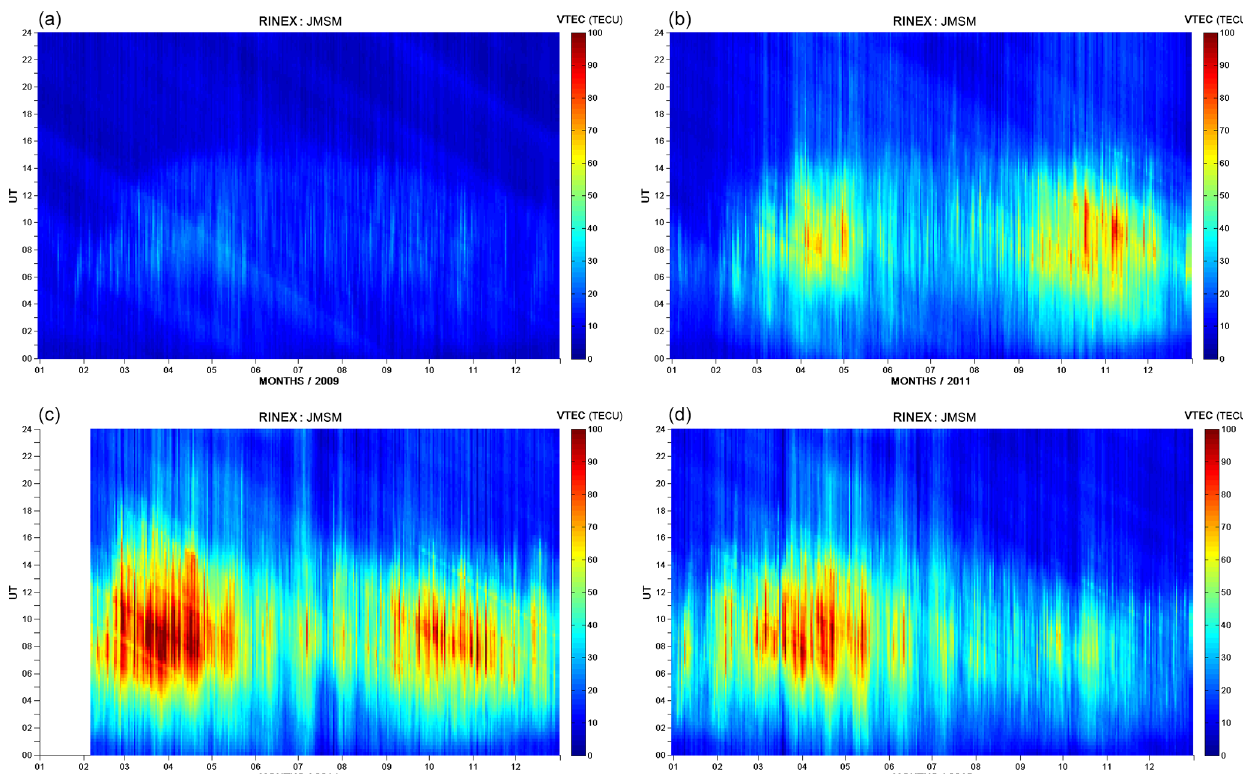
Figure 5. (a–d) A two-dimensional (2D) variation in vertical TEC according to UT at the JMSM station for one of the years of the minimum (2009), ascending (2011), maximum (2014) and descending (2015) phases of solar cycle